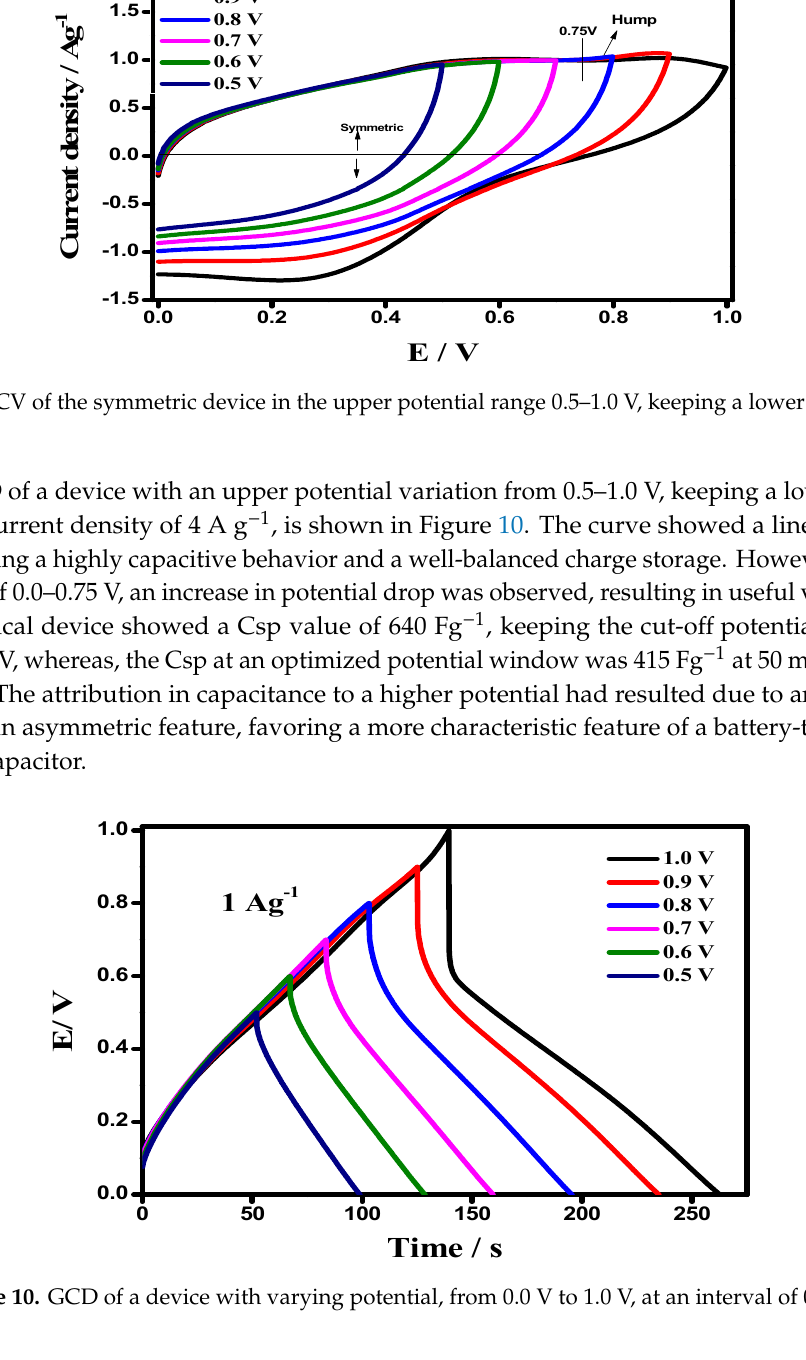
Figure 8. ( a ) Bode Plot with a relaxation time constant ( τ o ) and ( b ) capacitance vs. frequency response, of the synthesized PANI–DBSA.